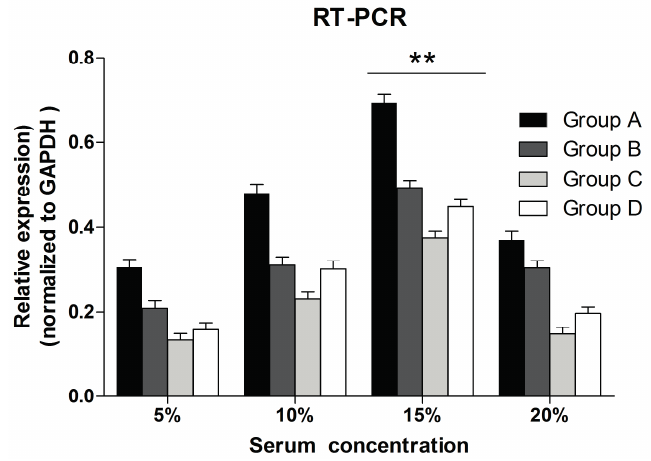
Figure 8. Quantitative RT-PCR assay was used to investigate the effect of different sera conditions on the expression of NT-3 genes in OEC. The NT-3 mRNA relative expression (normalized to GAPDH) of OEC in 15% serum was significantly different comparing with the OEC in 5% serum. The data was presented as mean ± SD. Two asterisks mean that there is statistically significant difference and p <